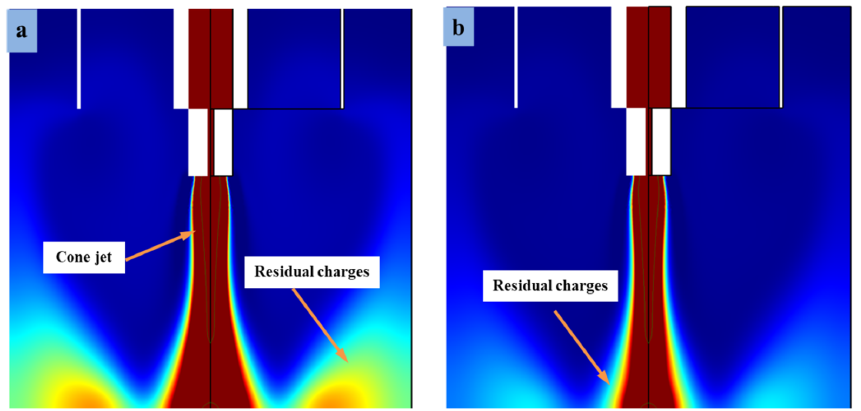
Figure 10. Different-sized microdroplets generated at higher flow rates of ( a ) 5.6 × 10 − 7 m 3 s − 1 and ( b ) 3.4 × 10 − 6 m 3 s − 1